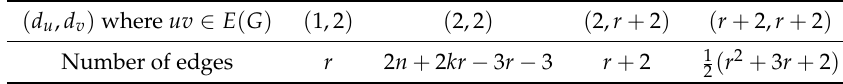
Table 9. The edge partition of the graph G for k >